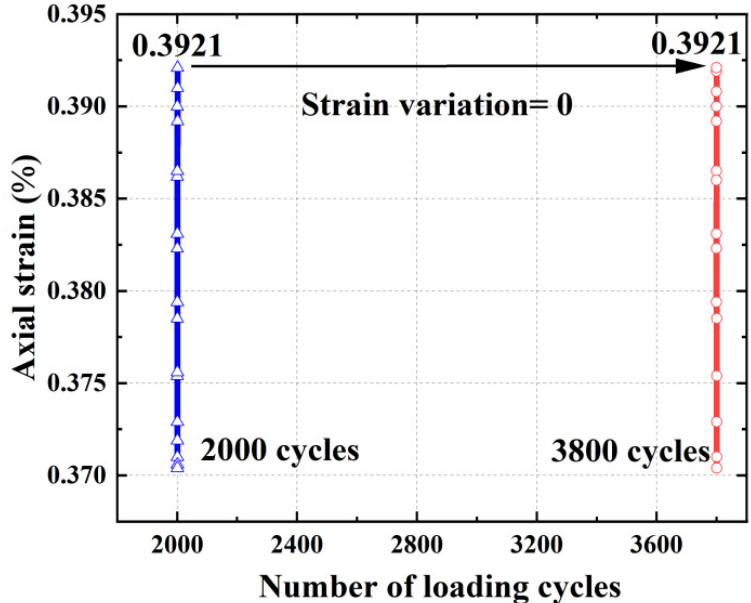
Figure 7. Cyclic curve in steady state.